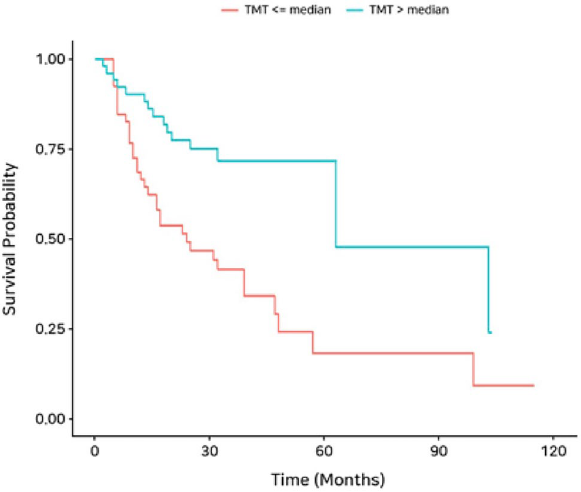
Figure 4. Kaplan–Meier curve for progression-free survival (PFS) according to median temporalis muscle thickness